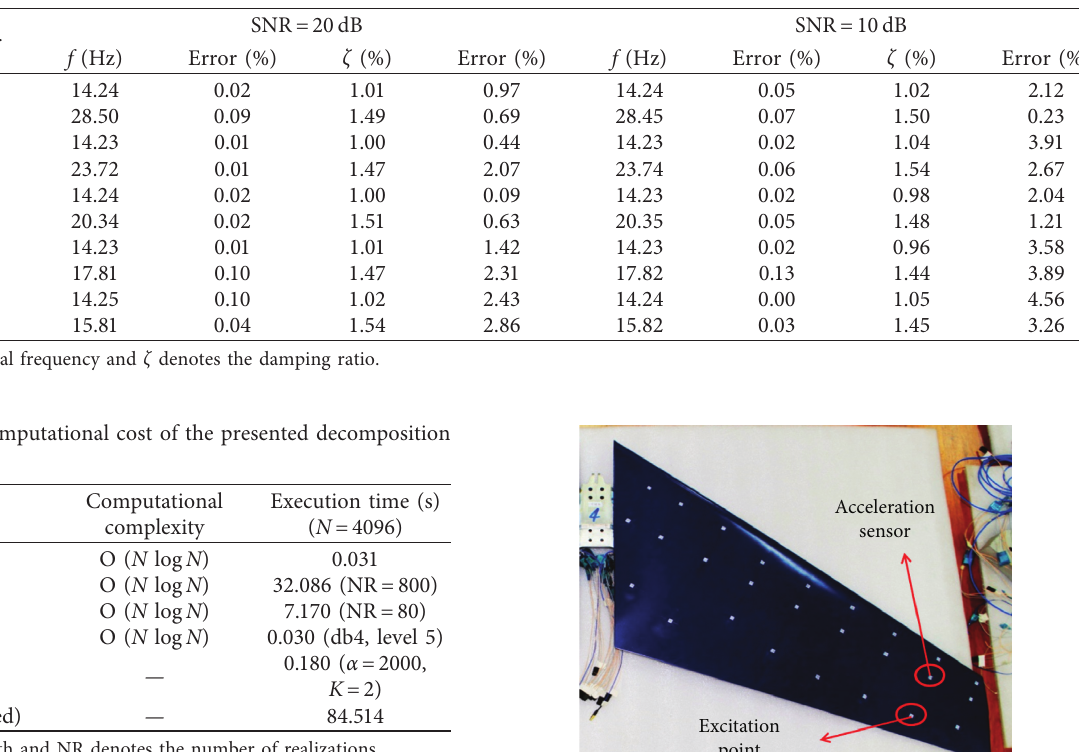
Table 1: The identified modal parameters.